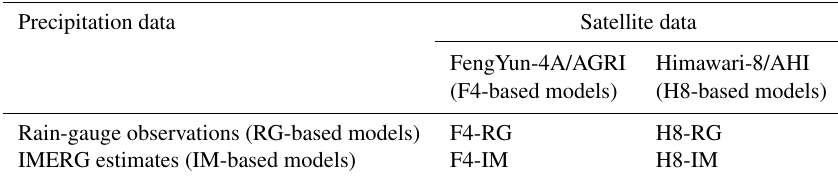
Table 3. Differences among the four precipitation integration models used in this paper.